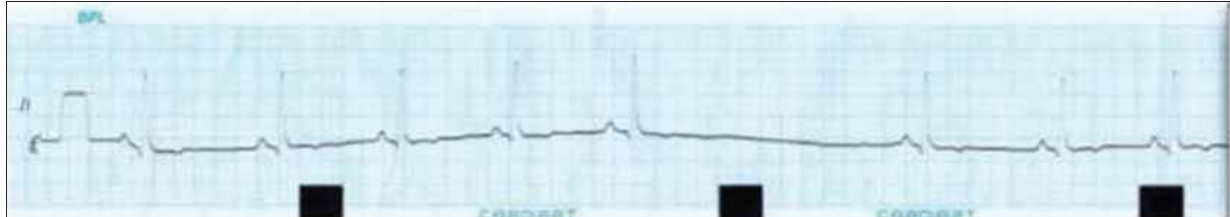
Figure-13: Electrocardiogram of animal depicting second degree AV